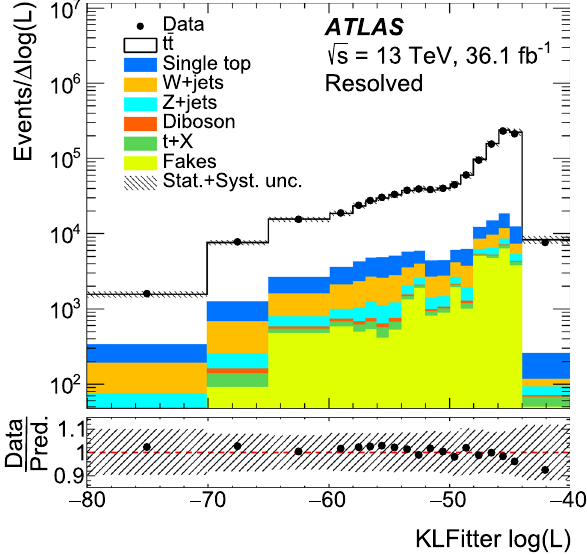
Fig. 5 Distribution in the (cid:3) + jets channel of the logarithm of the like- lihood obtained from the kinematic fit in the resolved topology. Data distributionsarecomparedwithpredictionsusing Powheg + Pythia8 as the t ¯ t signalmodel.Thehatchedarearepresentsthecombinedstatistical and systematic uncertainties in the total prediction, excluding system- atic uncertainties related to the modelling of the t ¯ t events. Underflow and overflow events are included in the first and last bins. The lower panel shows the ratio of the data to the total prediction. Only events with log L > − 52 are considered in the parton-level measurement in resolved